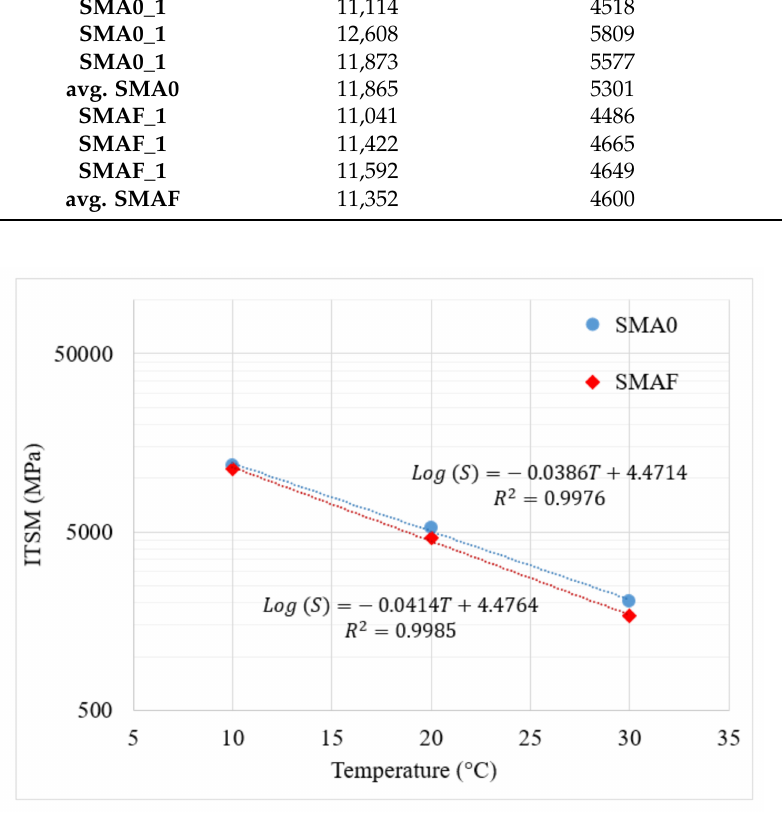
Figure 4. ITSM average results and temperature